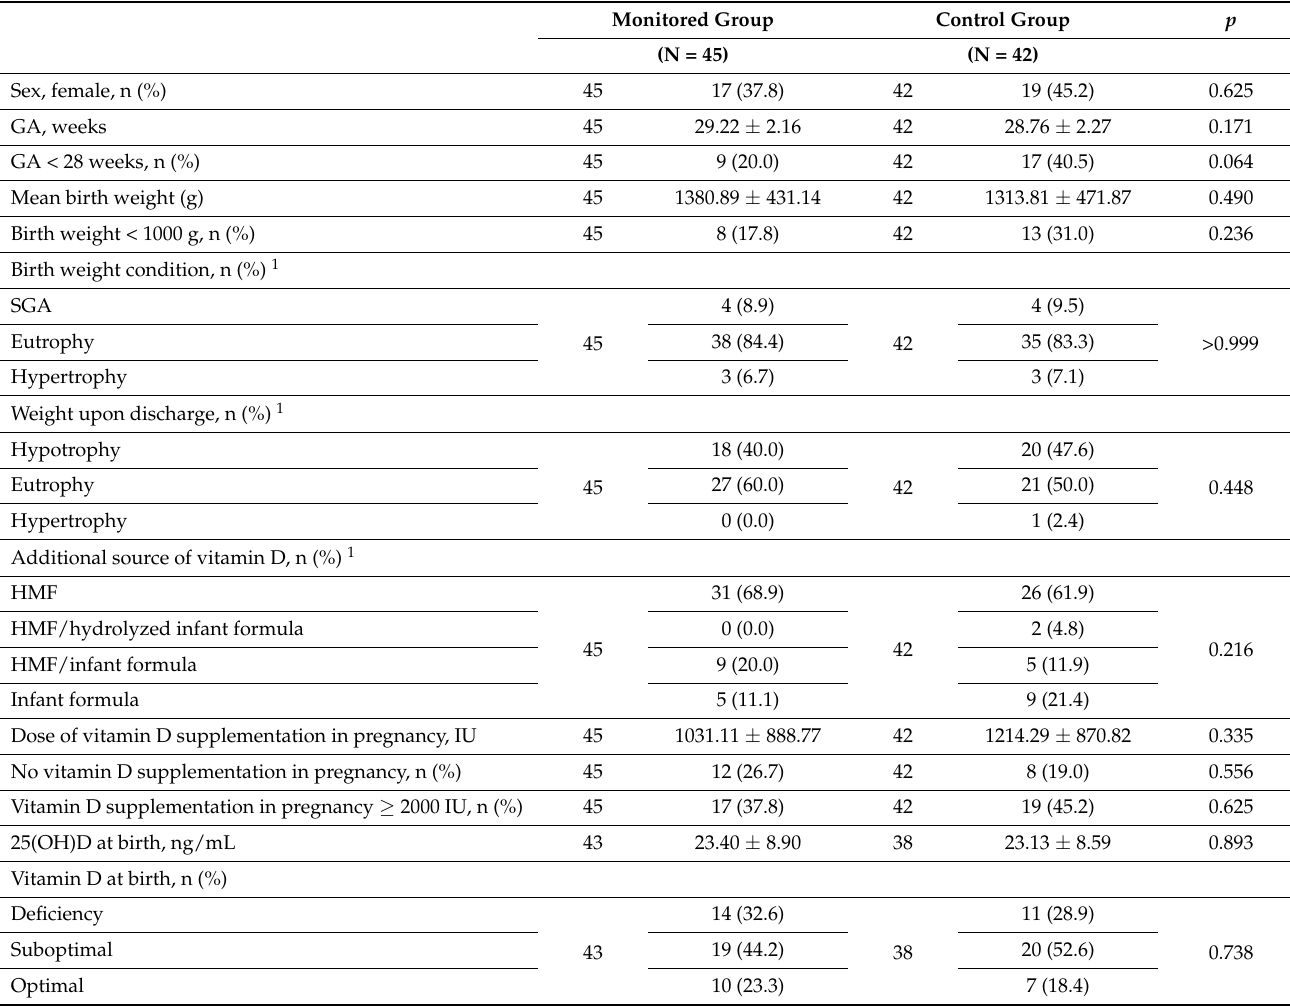
Table 1. Baseline characteristics of the study groups.